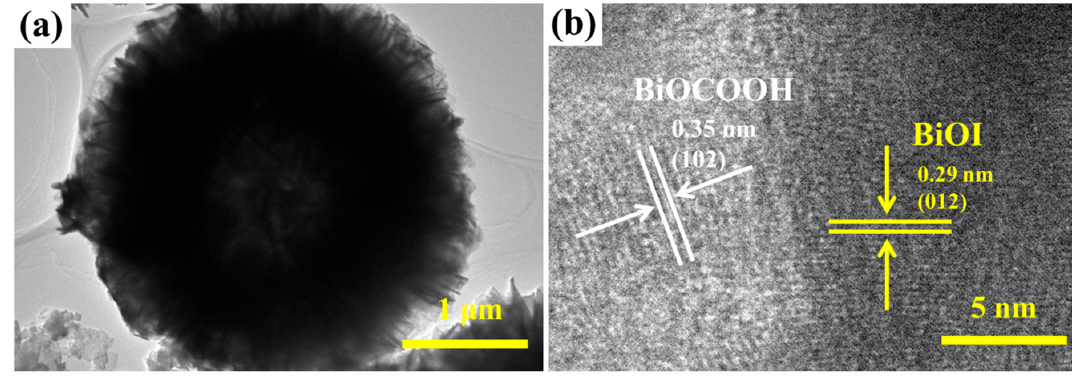
Figure 4. ( a,b ) TEM images of IBOCH-2. Figure 4. ( a , b ) TEM images of IBOCH-2.